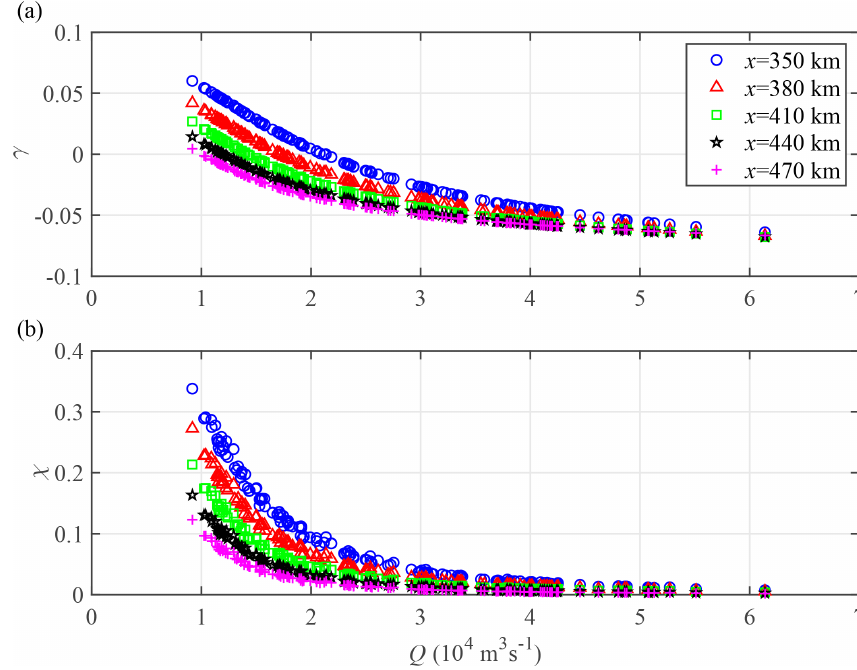
Figure 11. Relationship between the estuary shape number γ (a) , the friction number χ (b) and the river discharge Q